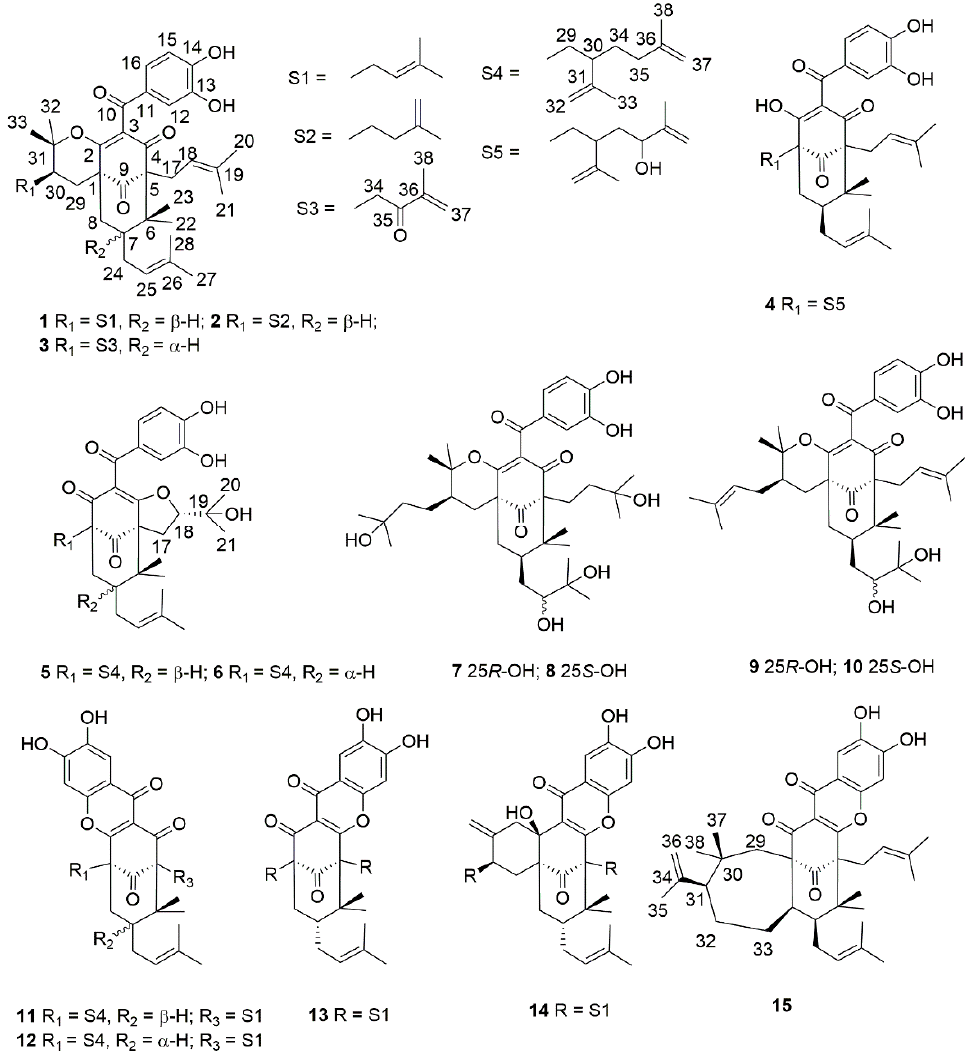
Figure 1. Chemical structures of PPAPs isolated from the fruits of G.